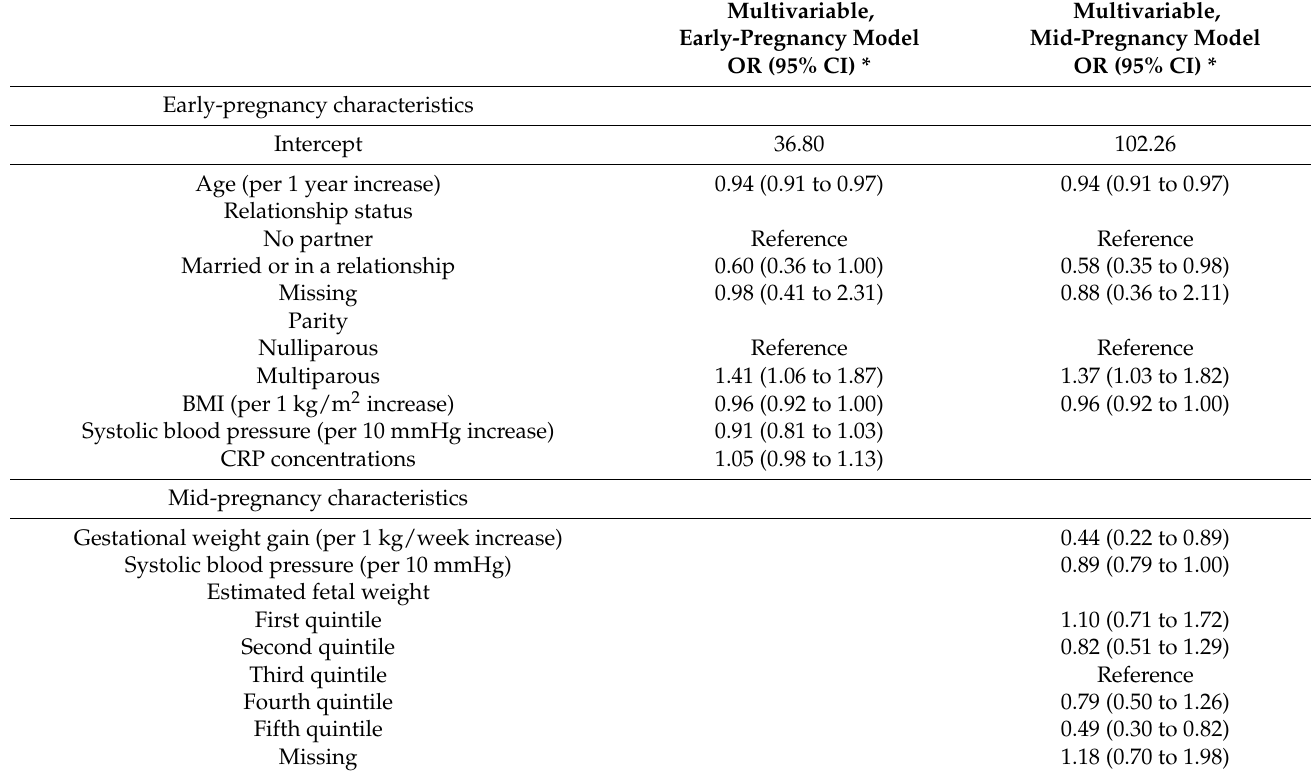
Table 3. Effect estimates of characteristics associated with no adverse outcomes.